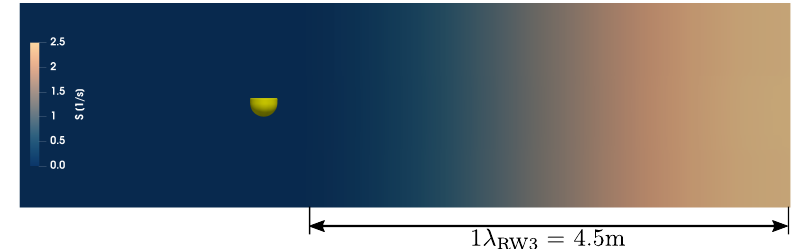
Figure 2. Side view of the computational domain: Screen shot of the S